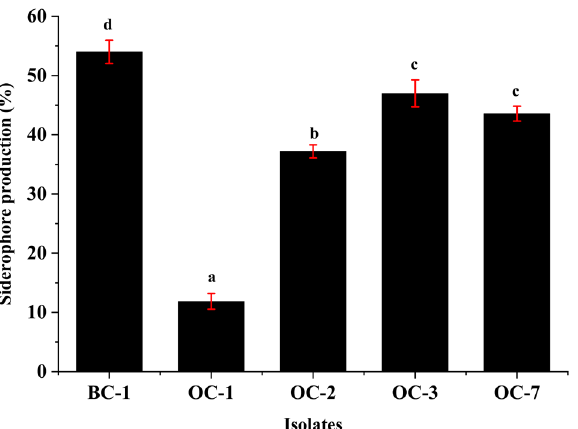
Figure 3. Quantitative estimation of Siderophore production by the potential Isolates. Results are expressed as means of three replicates and vertical bars shown in the figure represent standard deviations of the means. Significant differences among treatments explained by different alphabetical letters according to T’s-test at p ≤ 0.05 .